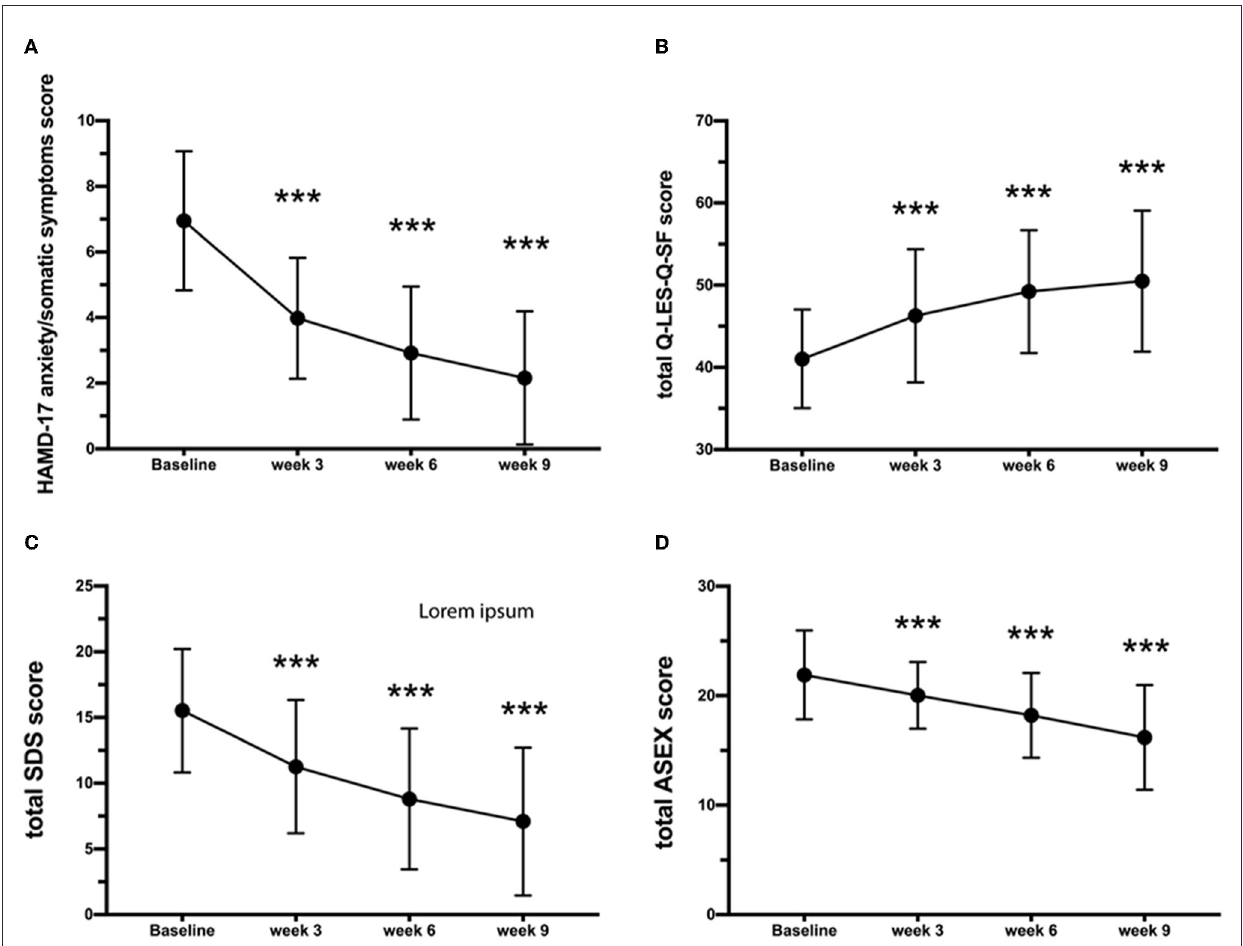
FIGURE2 Variations in (A) HAMD-17 anxiety/somatic, (B) Q-LES-Q-SF, (C) SDS, and (D) ASEX scores. Results are expressed as mean ± SD, analysis of variance for repeated measures. ***Statistically significant difference from baseline ( P < 0.001). Error bars represent standard deviations. HAMD-17, 17-item Hamilton Depression Rating Scale; QIDS-SR, quick inventory of depressive symptomatology self-report; CGI-S, clinical global impression scale; Q-LES-Q-SF, quality-of-life enjoyment and satisfaction questionnaire-short form; ASEX, Arizona sexual experiences scale; SDS, Sheehan Disability